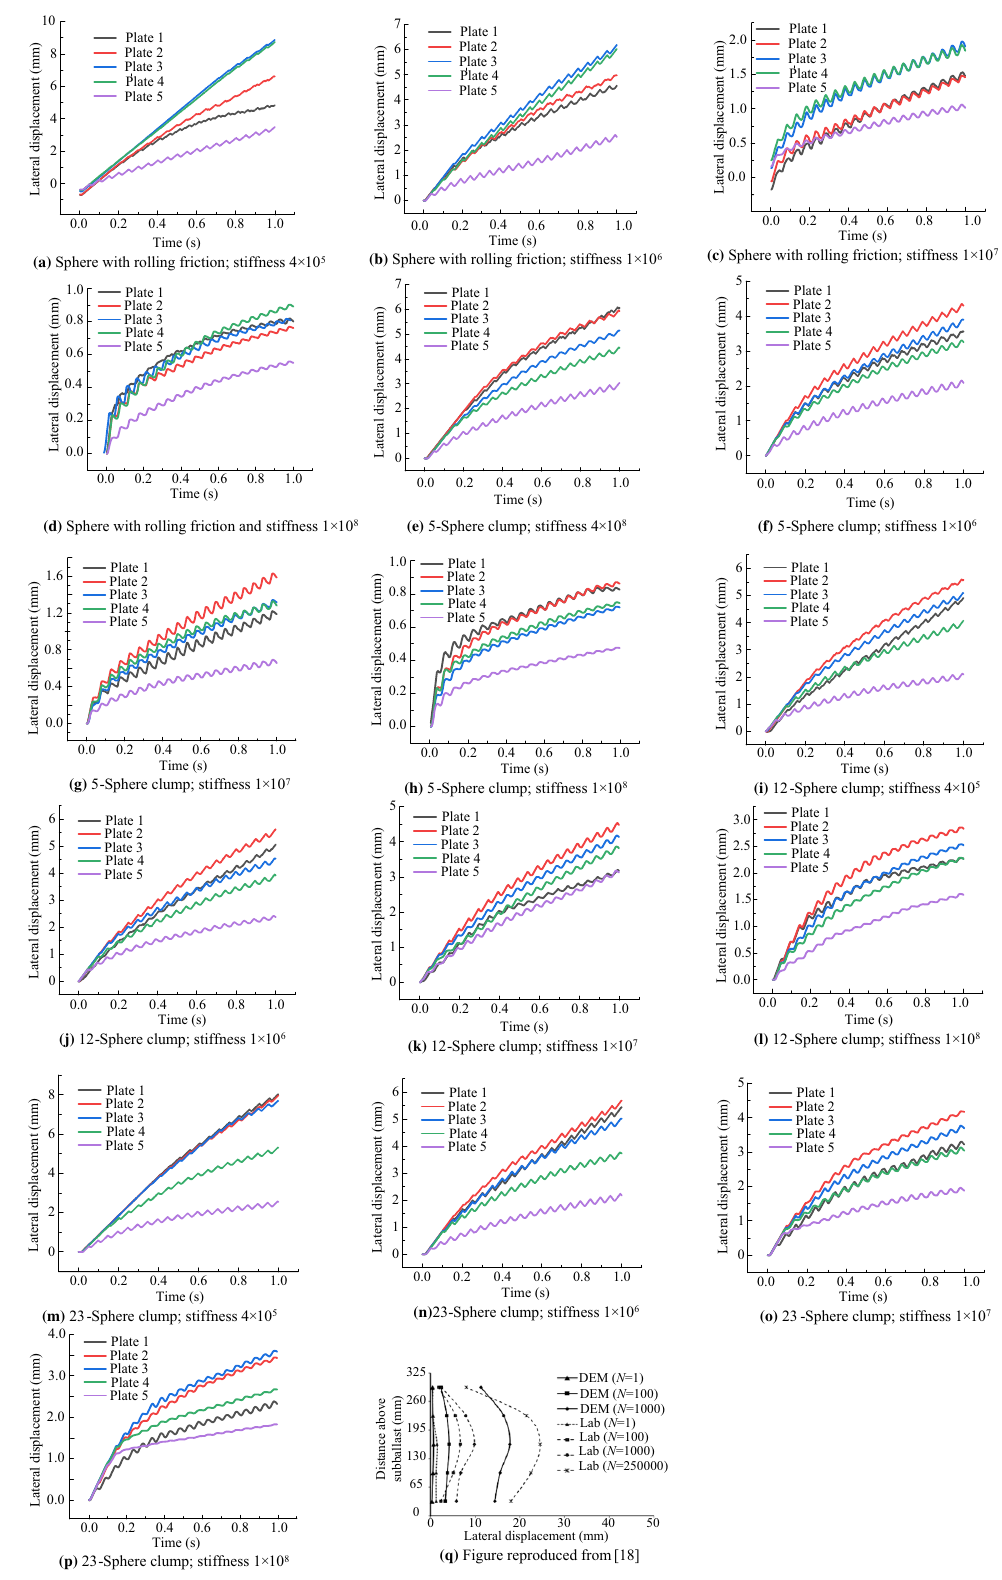
Fig. 12 Lateral displacement vs time of the five movable plates and the reference form literature